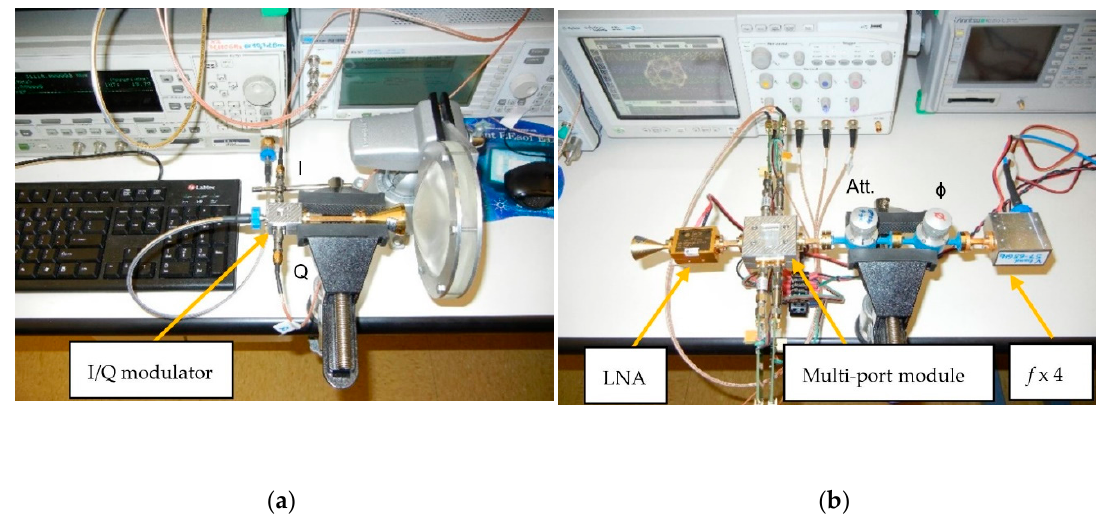
Figure 43. V-band multi-port test-bench: ( a ) transmitter side; ( b ) multi-port receiver side.